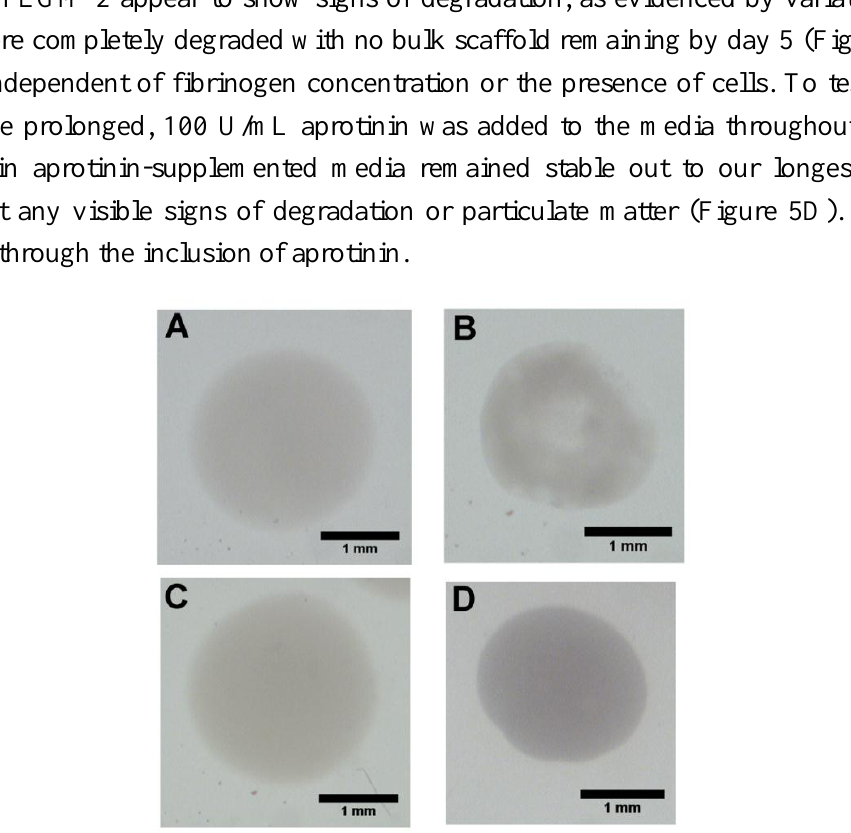
Figure 5. Longevity of Bead Structure: Beads were incubated in EGM-2 media and imaged at day 0 ( A ), day 4 ( B ), and day 5 ( C ). Beads incubated in media supplemented with 100 U/mL Aprotinin were imaged at 1 month ( D